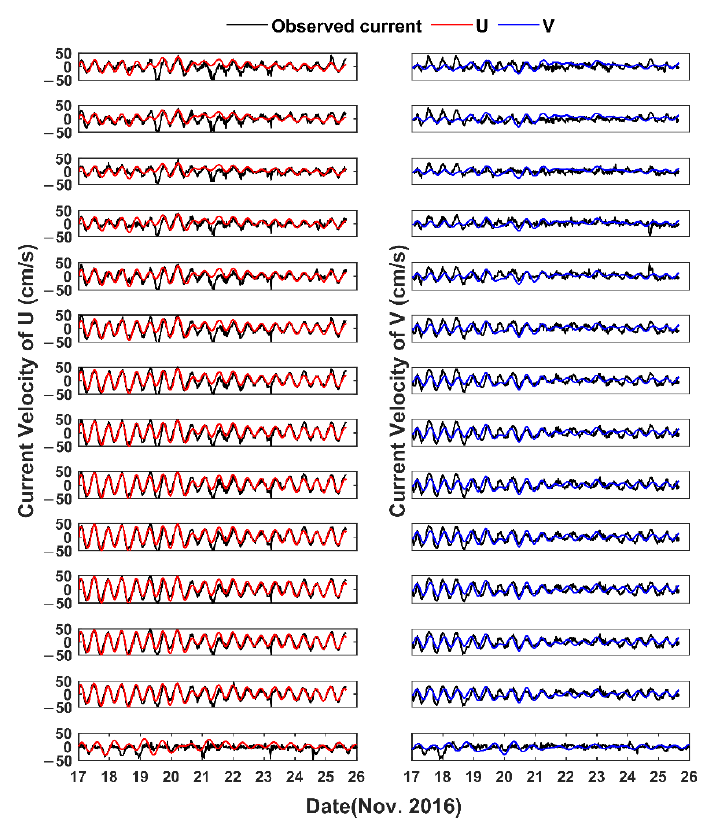
Figure 12. Temporal distribution of observed and inverted current velocities to the east ( left ) and north ( right ). The uppermost plots depict current velocities at a depth of 3 m with subsequent plots showing velocities at 2 m increments to a maximum depth of 29 m at the bottom. U and V denote the inverse current velocities in the zonal and meridional directions, respectively.